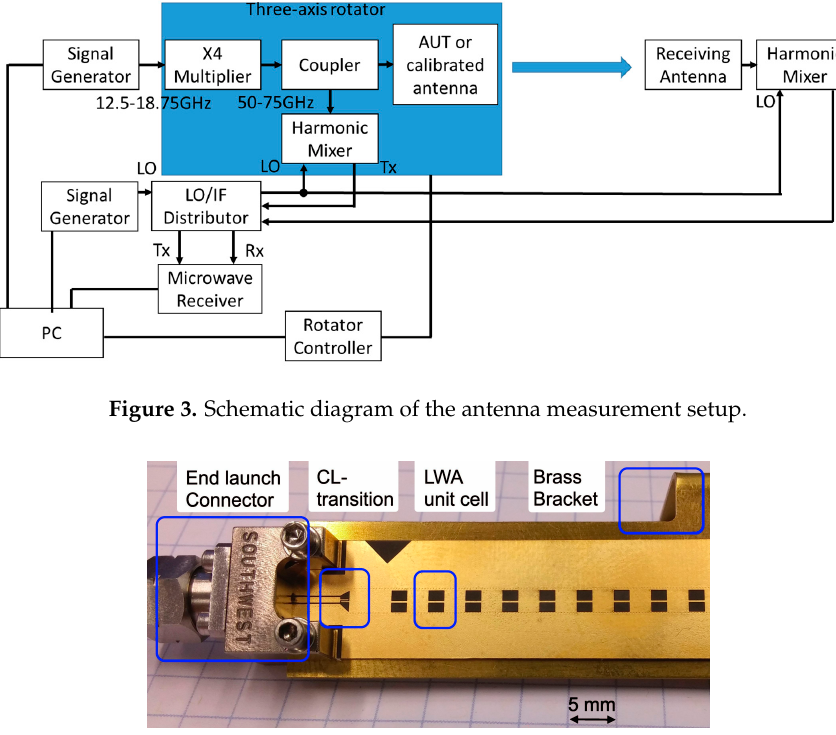
Figure 4. Photograph of the antenna assembly consisting of the fabricated SIW LWA PCB with coupled-line (CL) transition, brass bracket and coaxial end launch connector (ELC).